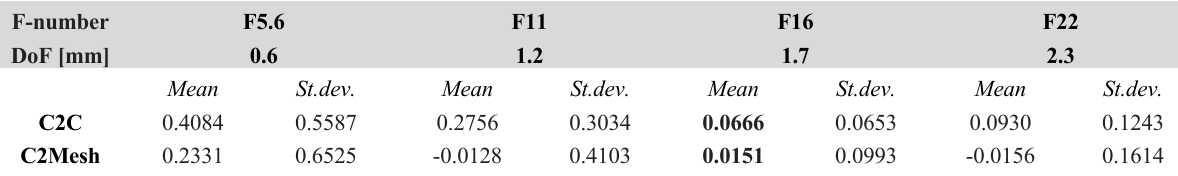
Table 2. Metric evaluation (Cloud-to-Cloud and Cloud-to-Mesh comparison [mm]) for the dense reconstruction of the 2-euro object performed with several aperture settings (105 mm focal length, 200 mm object distance).